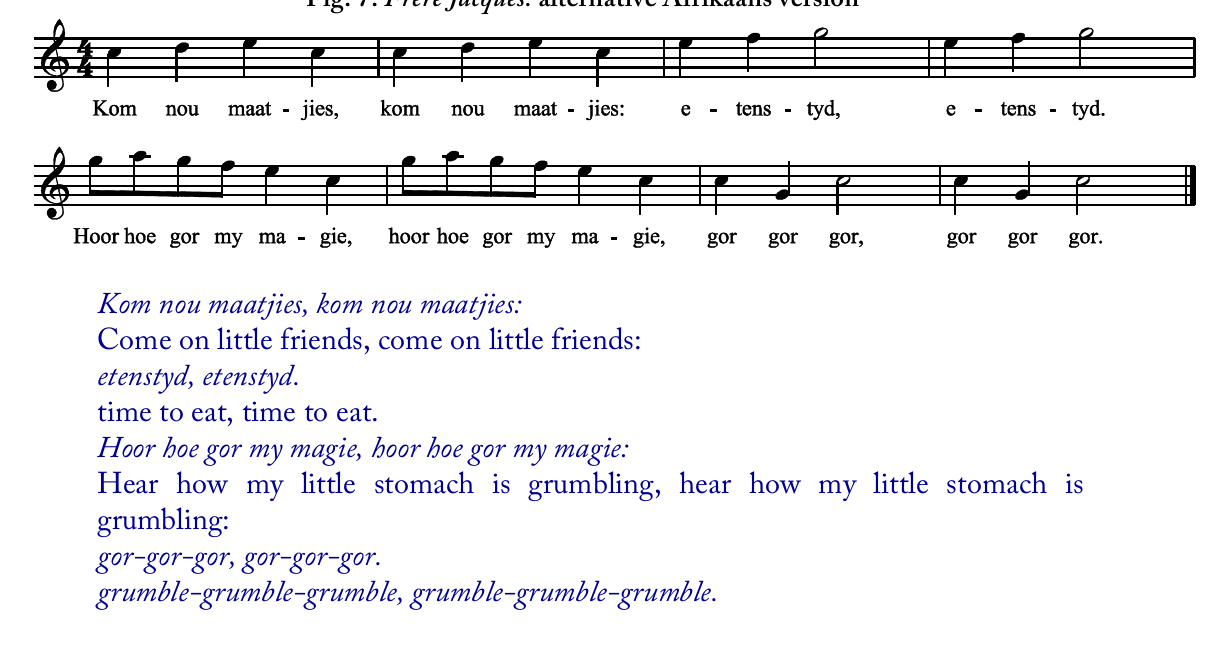
Fig. 7. Frère Jacques: alternative Afrikaans version